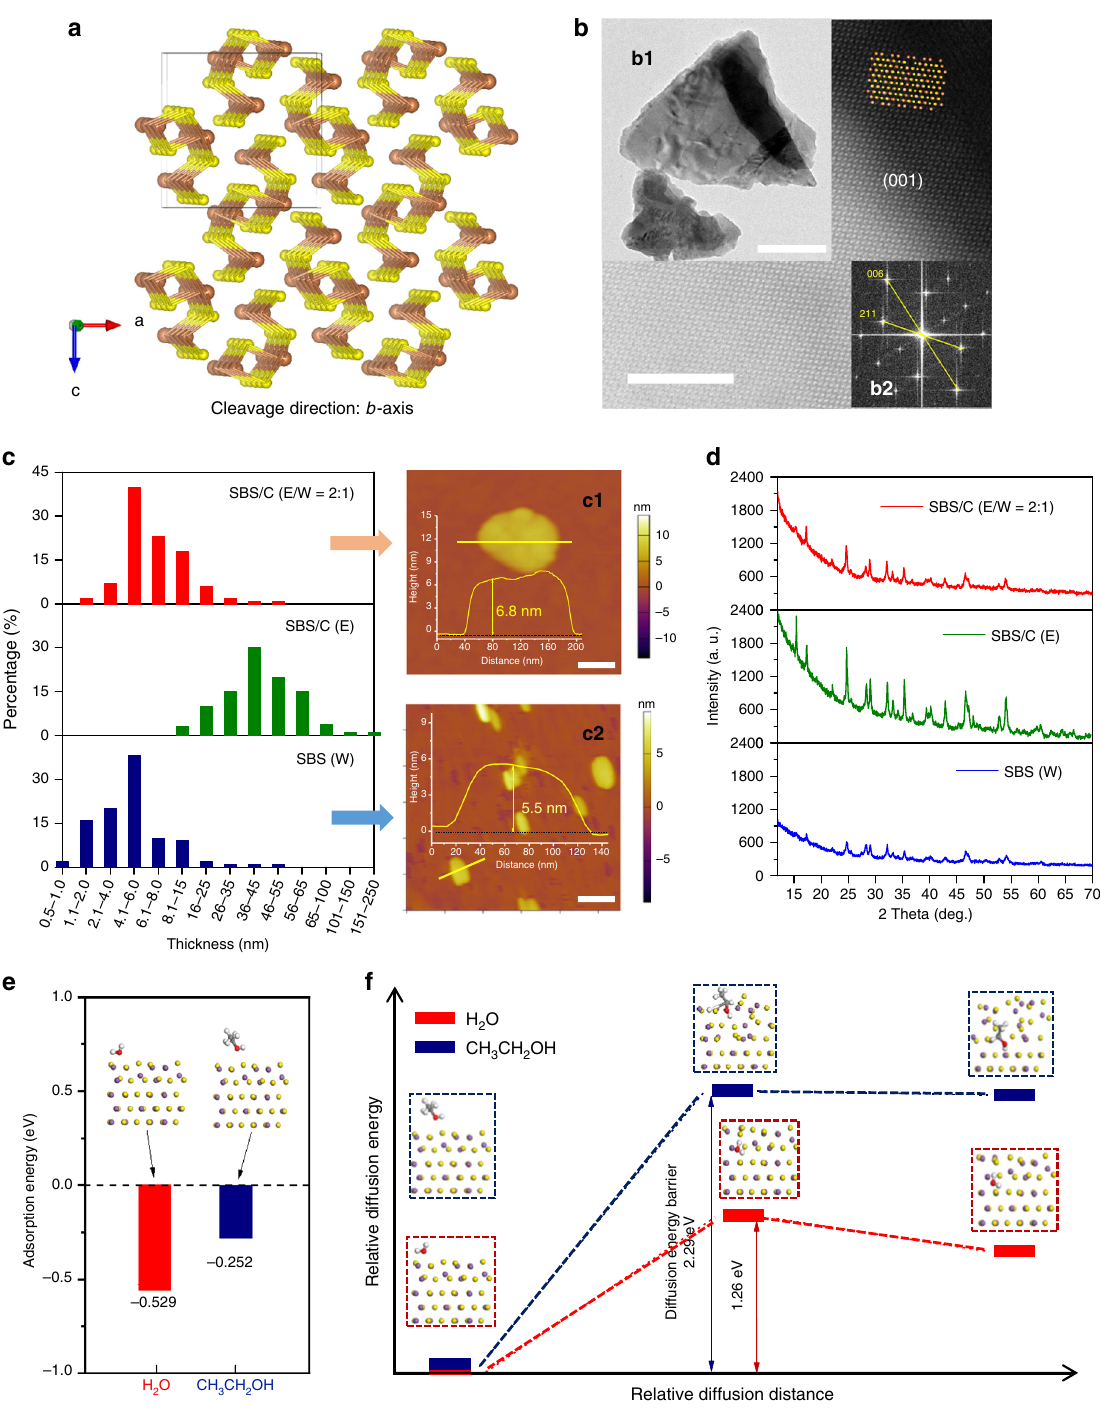
Fig. 2 The characterization of exfoliated SBS and the solvent effect for exfoliation. a The crystal structure of bulk Sb 2 S 3 with cleavage tendency along b -axis. b High-resolution TEM image of exfoliated Sb 2 S 3 with inset TEM image ( b1 ) and FFT pattern ( b2 ). c Histograms of the thickness distribution of SBS nanosheets prepared with different solvents (mixed ethanol and water (E/W = 2:1), pure ethanol (E), and pure water (W)), and typical AFM images with inset cross-sectional height pro fi les of SBS nanosheets obtained from SBS/C (E/W = 2:1, c1) and SBS (W, c2). d XRD patterns of exfoliated Sb 2 S 3 with different exfoliation solvents (mixed ethanol and water (E/W = 2:1), pure ethanol (E), and pure water (W)). e Adsorption energy of water and ethanol molecules on Sb 2 S 3 (010) surface. f Relative diffusion energy barrier of water and ethanol molecules diffusing along the [010] direction from the Sb 2 S 3 (010) surface to a position between the second and the third layers of Sb 2 S 3 (110) slab, calculated with DFT and presenting the diffusion transition state, initial state, and fi nal state with the indicated crystal structures. Scale bars: 5 nm ( b ); 200 nm ( b1 ); 100 nm ( c1 ); 200 nm ( c2